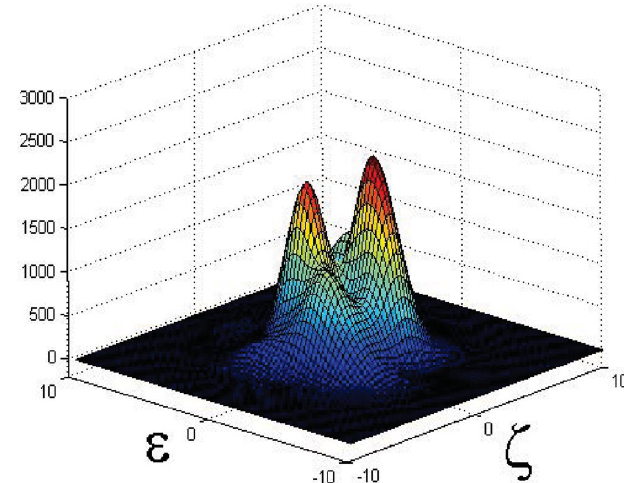
.FIG. 7. (Color) A longitudinal phase-space reconstruction of E beam in giant pulse mode using 2 streak-camera profiles, 6.82 (cid:15) apart, in the transition region (turn 225). Noticeable double hump and hot spot at (cid:6) < 0 and (cid:4) (cid:3) 0 is remarkably similar to prediction of theory in 10,11.